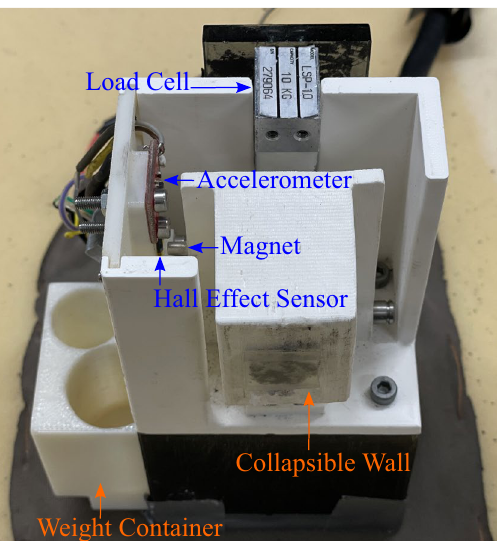
Figure 2. The instrumented object simulates breaks using a hinged, collapsible wall and is capable of measuring grip force and object movements with a load cell and